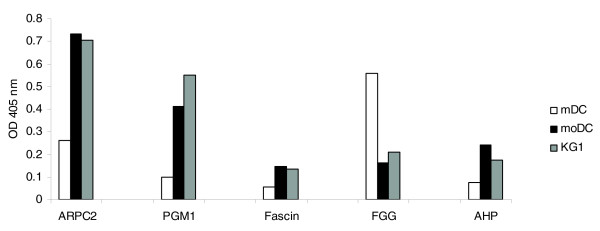
ELISA detection of cell lysate proteins. Differentially expressed digoxigenin-labeled proteins of mDCs, moDCs and KG-1 cell lysates were captured by specific antibody coated plates and detected with a polyclonal anti-dioxigenin Fab fragment. Data are representative of two experiments.